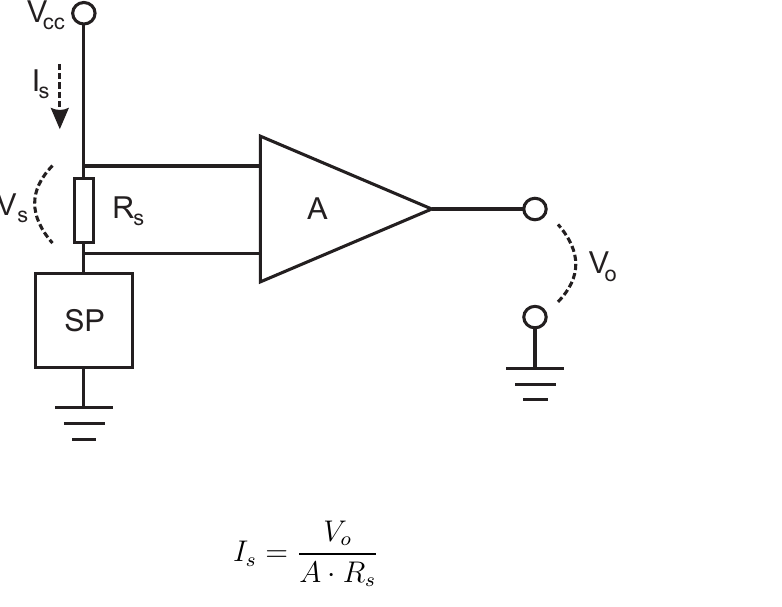
Figure 6. Current measurement setup. SP indicates Sensor Platform and A indicates amplifier. V is measured at 50 kHz by an A/D data acquisition card. o